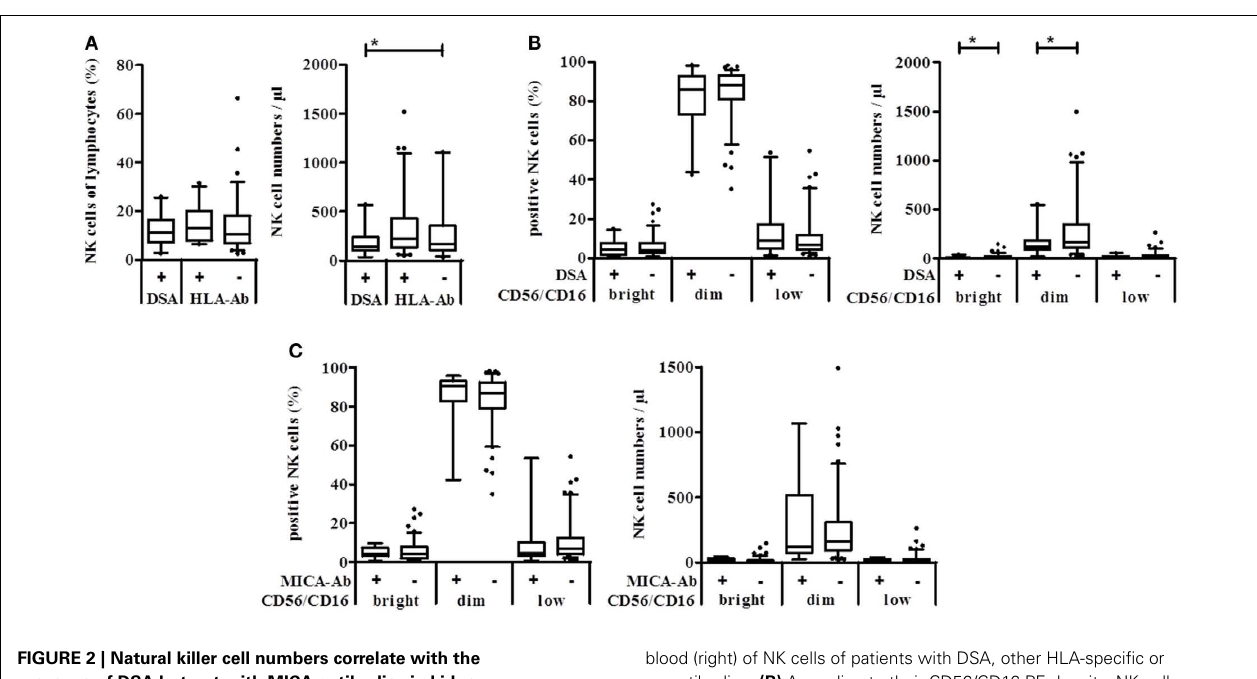
FIGURE 2 | Natural killer cell numbers correlate with the presence of DSA but not with MICA antibodies in kidney transplanted patients. Anti-HLA class I, class II, and MICA antibodies were detected in sera of kidney transplanted patients using the Luminex technology. Absolute NK cell numbers and % NK cells of lymphocytes were measured usingTrucount™ FACS staining of patient blood samples. (A) Percent (left) or absolute number per µ l